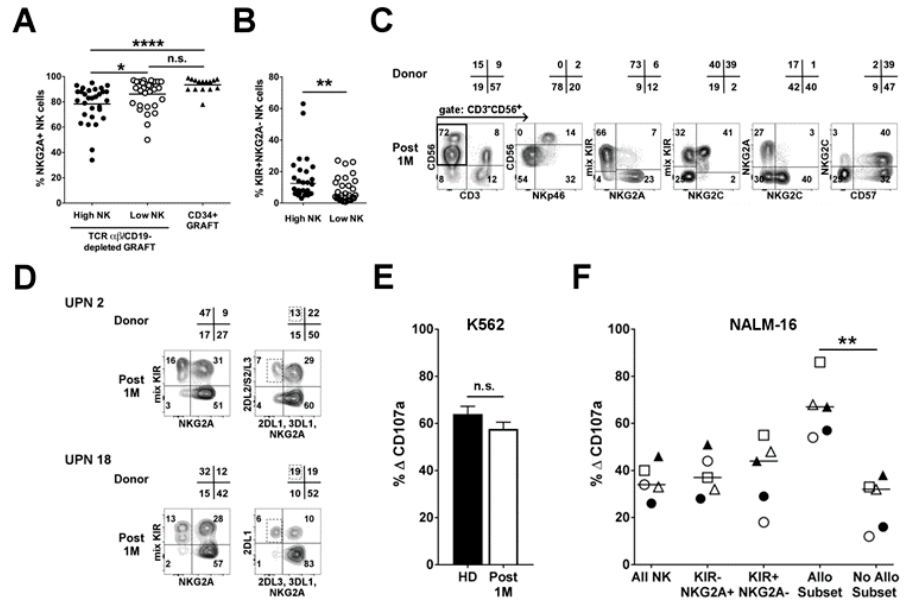
Figure 2. Evidence of mature and functional donor-derived NK cells in the patient repertoire at one month after HSCT. Cytofluorimetric analyses of NK cells (CD3 − CD56 + gated peripheral blood mononuclear cells, PBMC) derived from patients at 1 month after αβ T/B-depleted haplo-HSCT. ( A ) Percentages of NKG2A + cells in patients who received either high ( n = 30) or low ( n = 30) NK cell numbers (> or < 34.6 × 10 6 /kg, respectively), in comparison with CD34 + ( n = 15) engrafted patients. * p < 0.05, **** p < 0.0001 (Kruskal–Wallis test with Dunn’s post-test). Horizontal bars indicate the medians. ( B ) Percentages of KIR + NKG2A − cells in patients who received grafts containing either high ( n = 26) or low ( n = 30) NK cell numbers. ** p < 0.01 (Mann–Whitney test). Horizontal bars indicate the medians; ( C ) analysis of NK-cell repertoire in a representative patient (UPN77) infused with high cell numbers of NK cells characterized by an “adaptive” phenotype. The respective percentages of donor NK cells are also reported over the plots; ( D ) NK cell expression of KIR and NKG2A (left) and detection of alloreactive subset (right) in two representative patients, both infused with high NK cell numbers, are shown. The corresponding percentages of donor NK cells are also reported over the plots. The alloreactive subset is indicated as a dotted square. ( E ) Degranulation activity against K562 cells of NK cells from patients at one month after haplo-HSCT (post 1M, n = 6) in comparison to NK cells from healthy donors (HD, n = 27). E:T ratio 2:1. Data are shown as mean + SEM; n.s., no significant p -values (Mann–Whitney test). ( F ) Degranulation activity against NALM-16 of NK cells from patients (each identified by a different symbol) at 1 month after haplo-HSCT. E:T ratio 2:1. Different NK cell subsets, including the Allo C2 NK cell subset (Allo Subset), are compared. No Allo Subset represents NK cells expressing iKIRs specific for ligands on target cells. Horizontal bars indicate the medians. ** p < 0.01 (Kruskal–Wallis test with Dunn’s post-test).